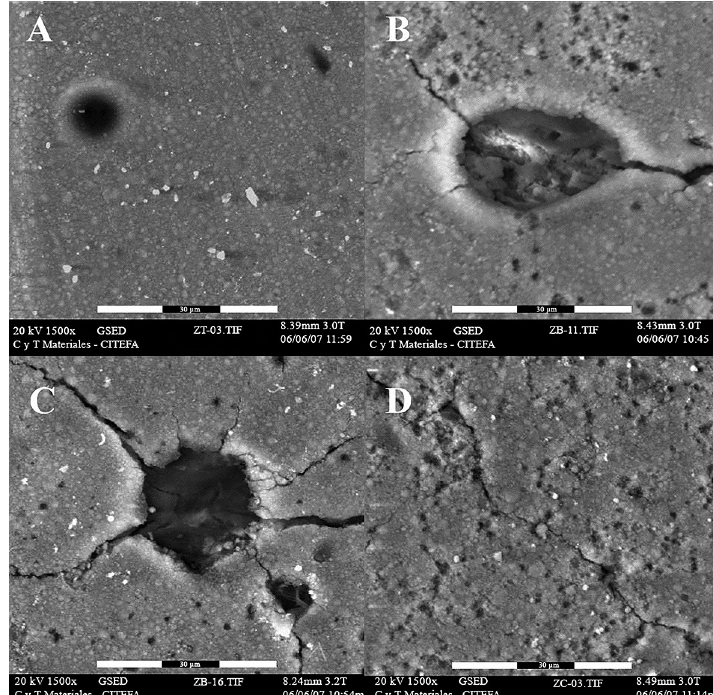
Figure 6- Representative ESEM micrographs of Filtek Z250 at 0 (A), 500 (B), 1000 (C) and 1500 (D) UV accelerated aging hours. Images were taken at 1500x magnification